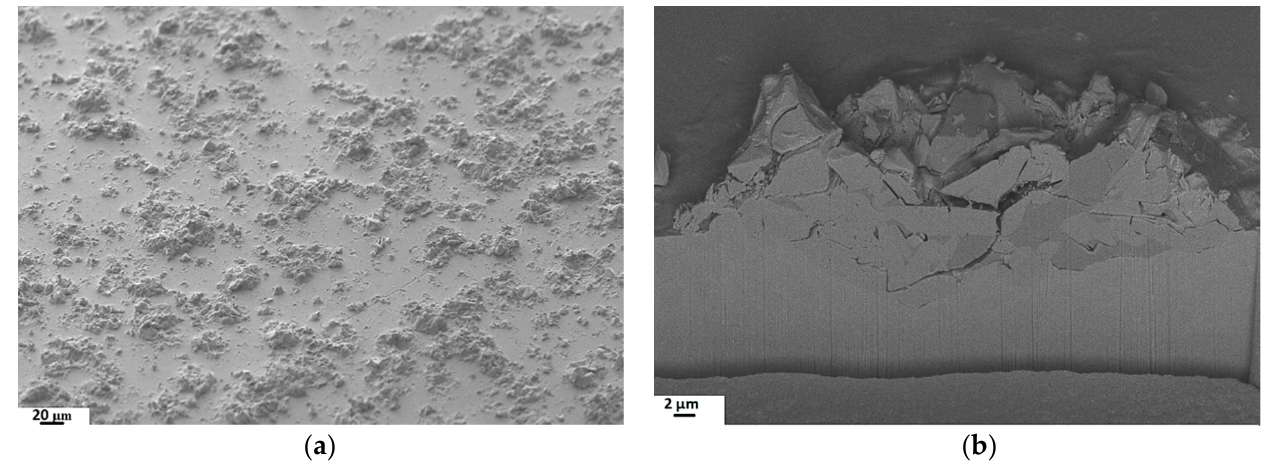
Figure 7. SEM images of Ti 3 AlC 2 sprayed particles at ~730 m/s on TA6V: ( a ) top view; ( b ) FIB cross-section.